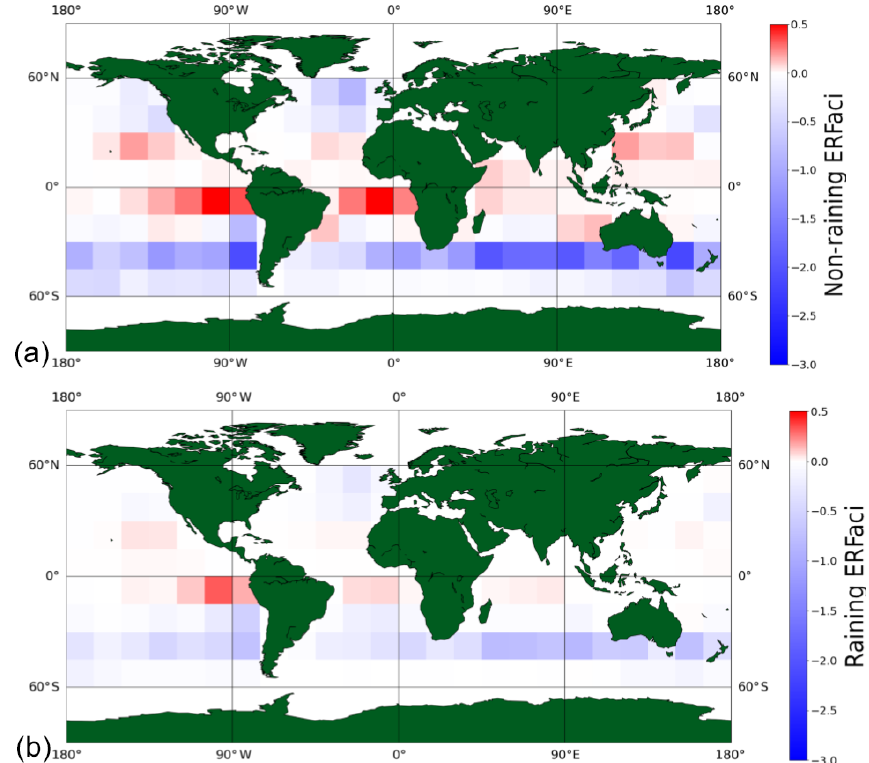
Figure 8. The decomposed effective radiative forcing due to aerosol–cloud interactions found as a sum of its components on a regional scale within regimes of EIS, RH, and LWP for (a) non-raining clouds ( − 0 . 147Wm − 2 ) and (b) raining clouds ( − 0 . 06Wm − 2